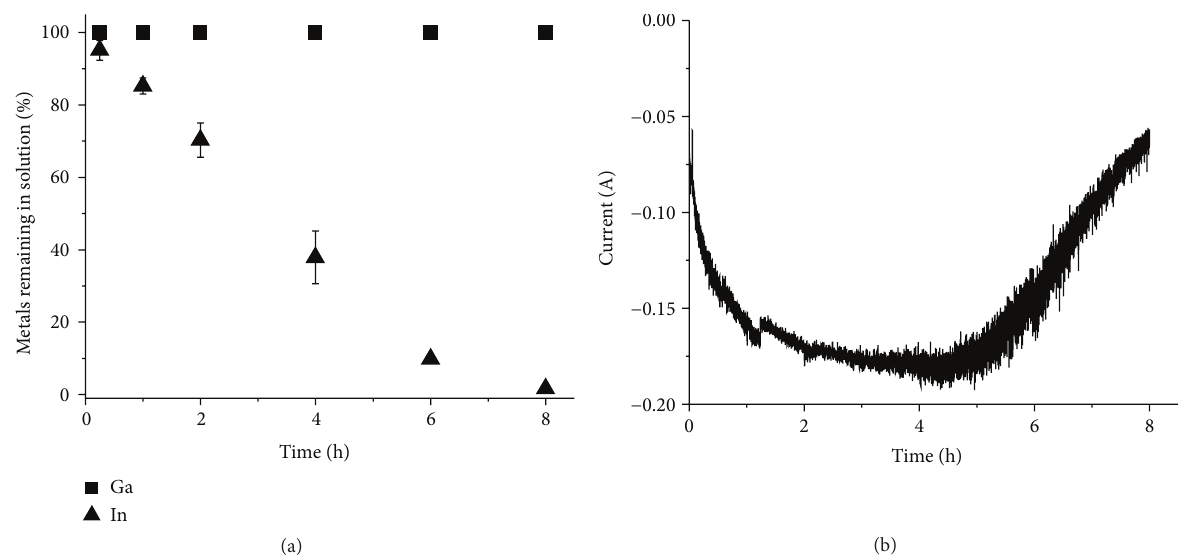
Figure 7: Electrochemical separation of indium from the synthetic solution containing copper(II), indium(III), and gallium(III) in 1M HCl (Solution 1). (a) The metal concentration in the solution relative to the original concentration as a function of time. (b) The current passed though the circuit as a function of time.